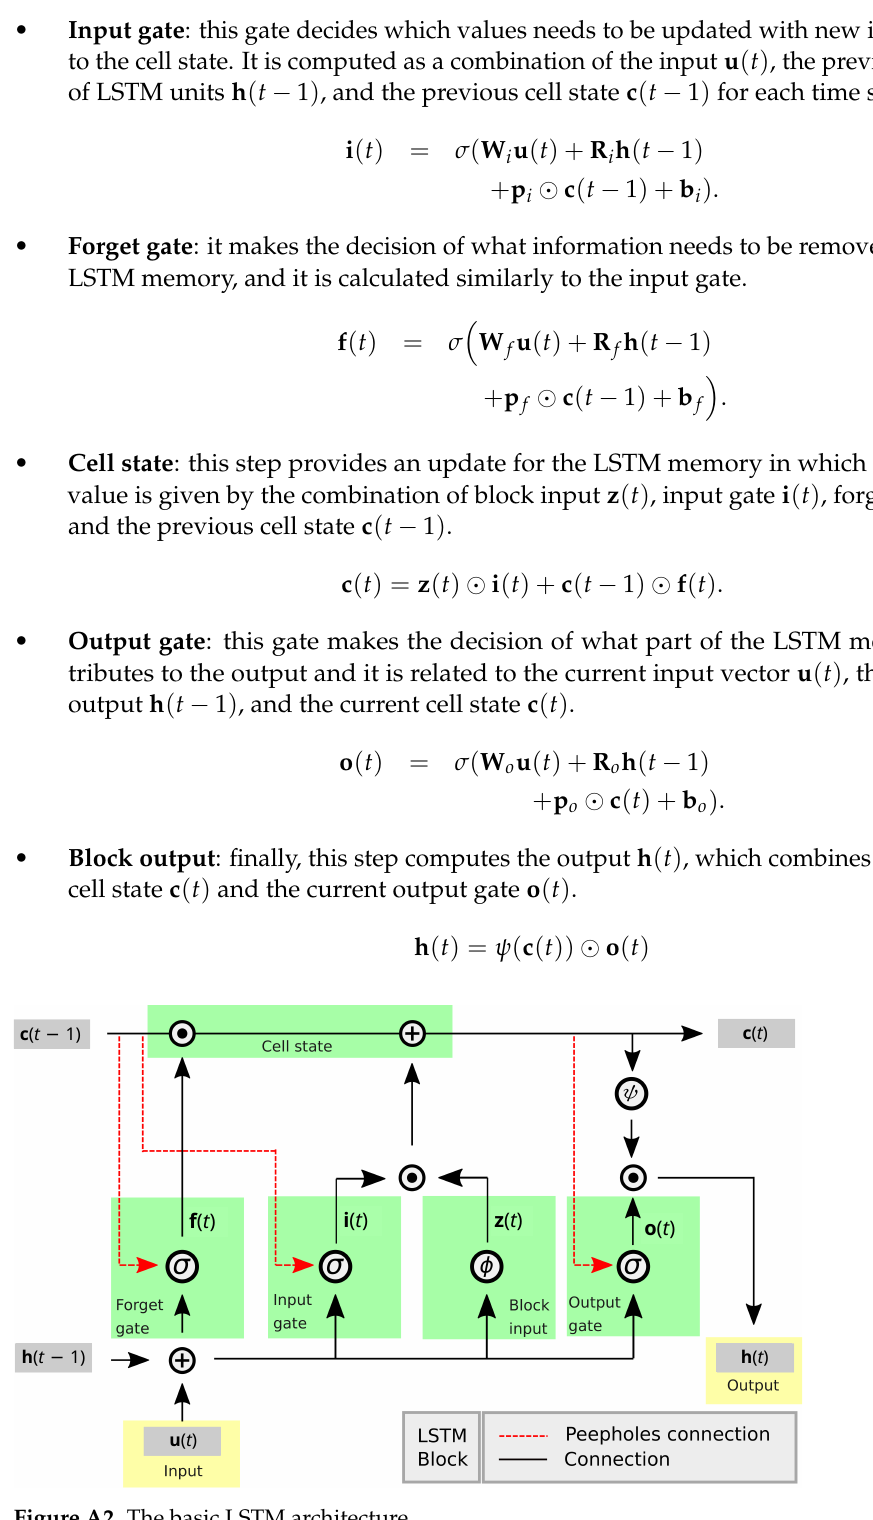
Figure A2. The basic LSTM